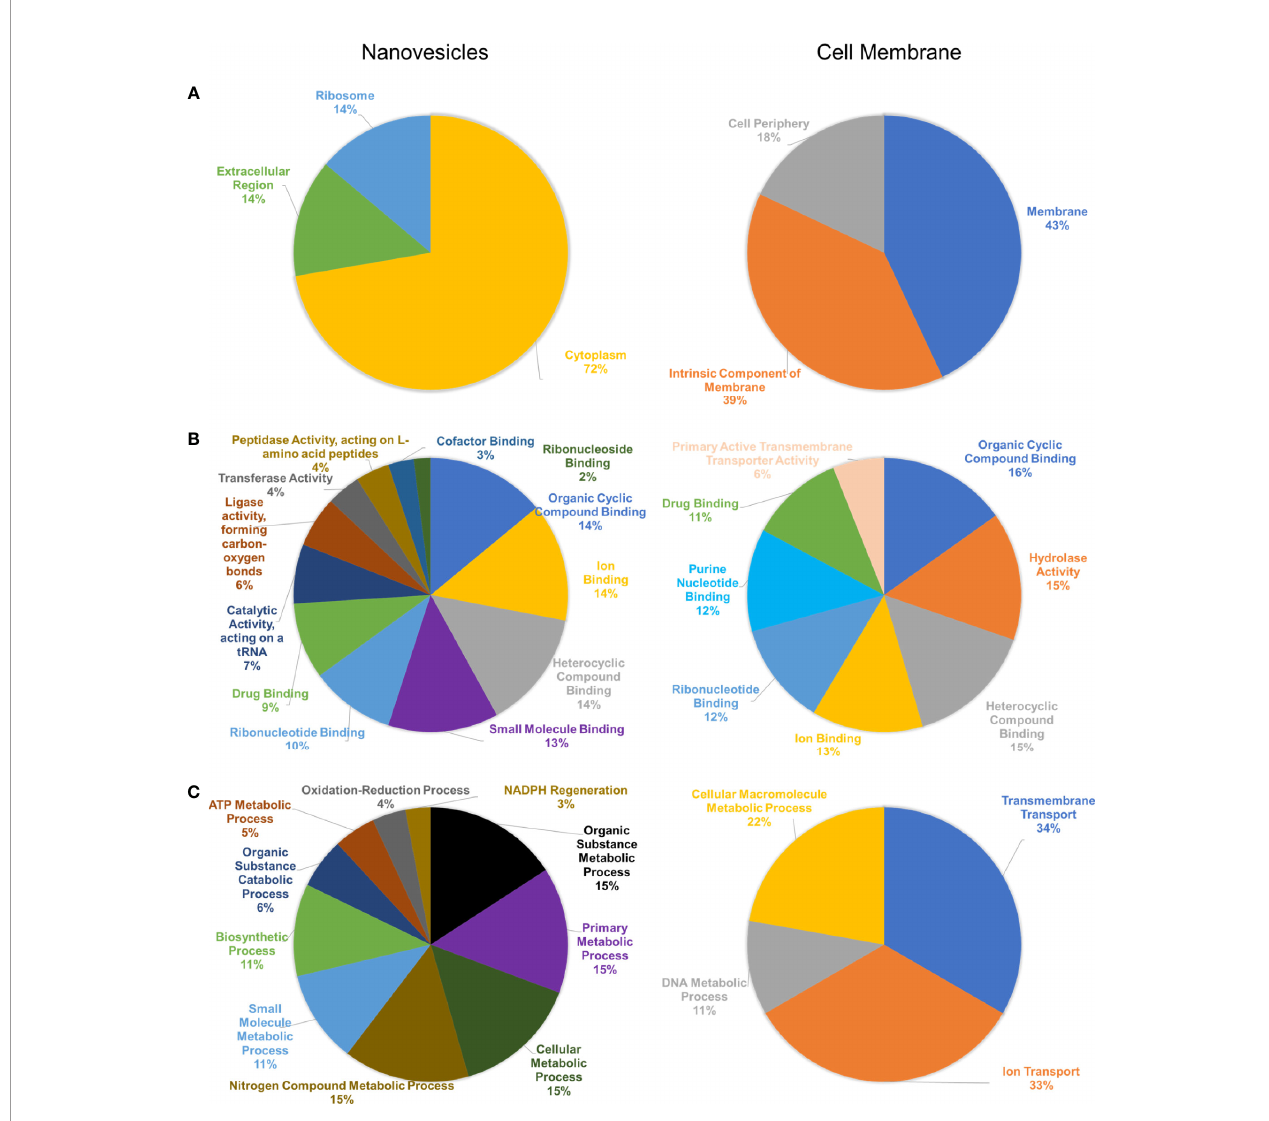
FIGURE 3 | Bioinformatic analysis of protein composition of NV and CM from L. johnsonii N6.2. (A) Cellular component GO terms of NV (left) and CM (right). (B) Molecular function GO terms of NV (left) and CM (right). (C) Biological processes GO terms of NV (left) and CM